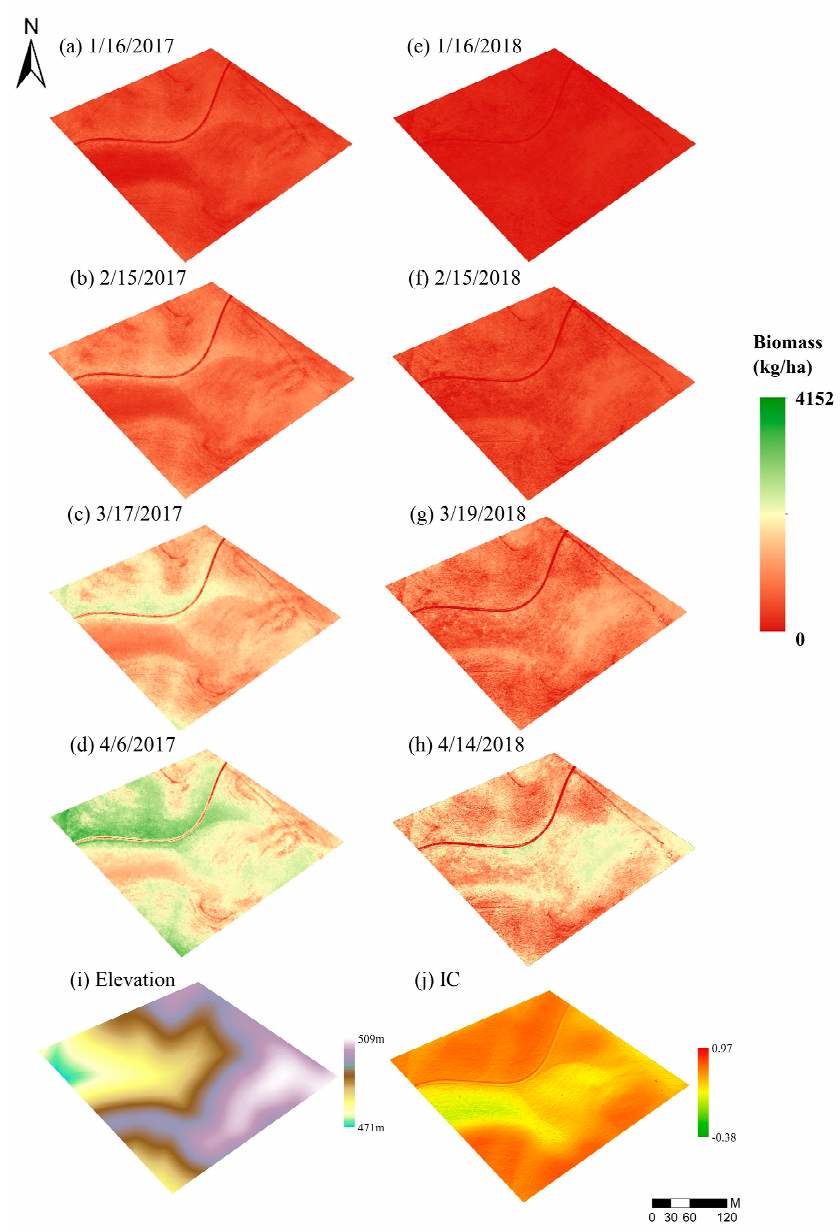
Figure 10. Spatial distribution of the estimated biomass on days with sUAS flights during 2017 and 2018 growing seasons ( a – h ). Also shown are elevation ( i ) and illumination condition (IC) maps ( j ) .